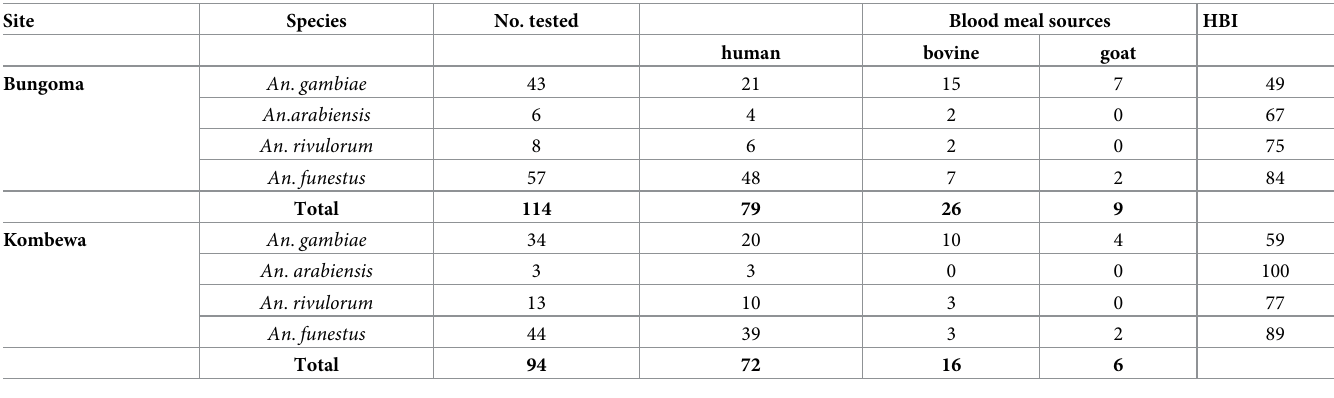
Table 5. Blood meal sources of Anopheles mosquitoes sampled from indoors in Bungoma and Kombewa, November 2019 to November 2020. Site